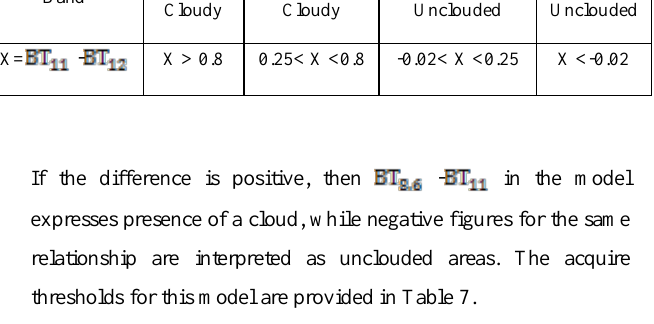
Table 7: Acquired thresholds for BT 8.6 - BT 11 (April 20 th )